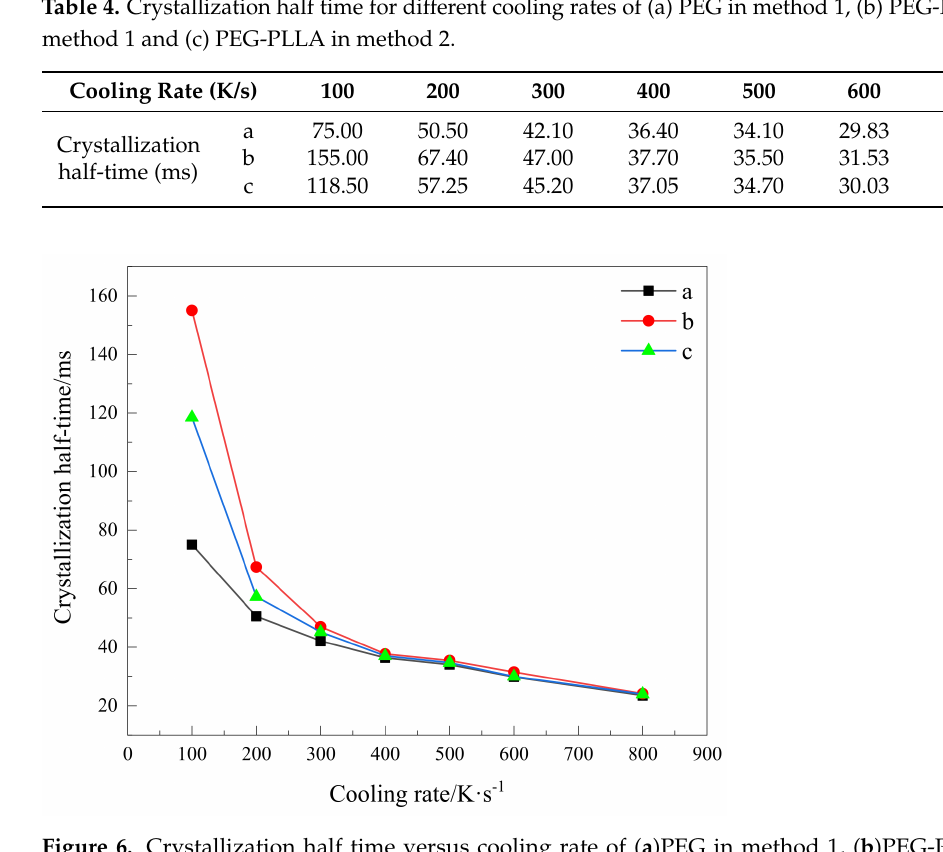
Figure 6. Crystallization half time versus cooling rate of ( a )PEG in method 1, ( b )PEG-PLLA in method 1 and ( c )PEG-PLLA in method